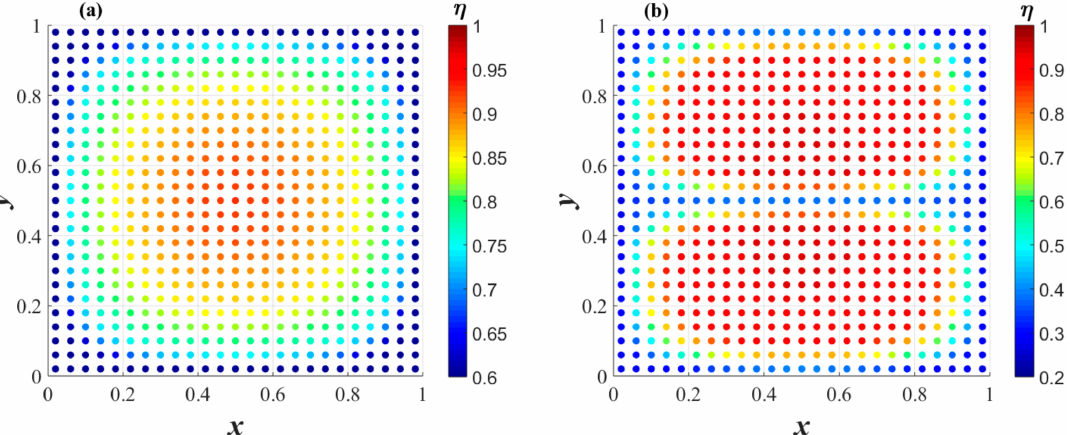
Figure 5. The energy dissipation ratios of five NESs at different positions when f = 5: ( a ) ( p 1 = 0.5, p 2 = 0.5 ) ; ( b ) ( p 1 = 0.5, p 2 = 0.3 )